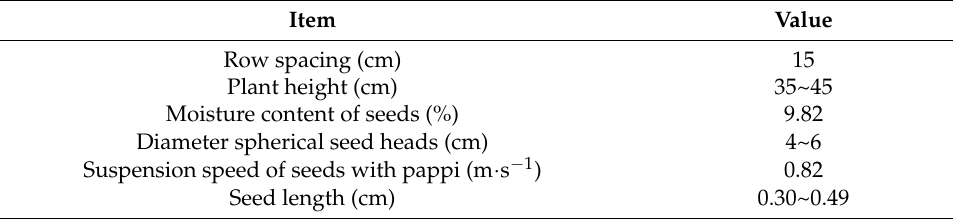
Table 2. Material characteristics of dandelion plants and seeds.